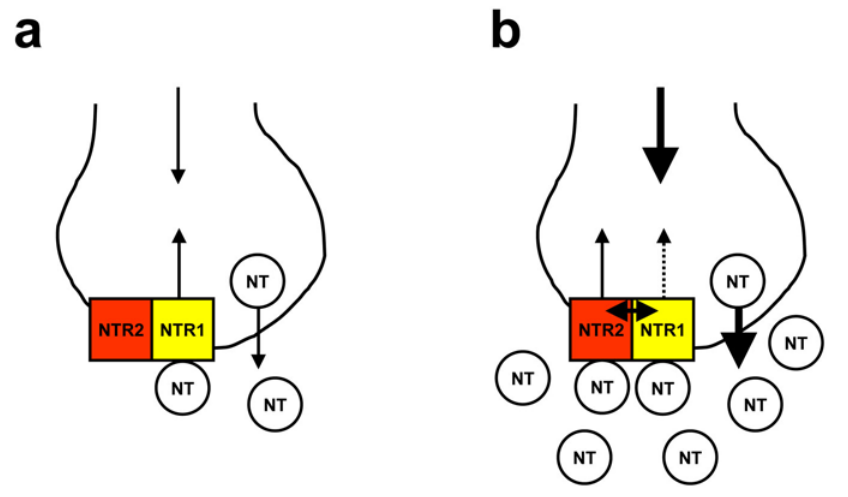
FIGURE 1. Heteromers of isoreceptors: “concentration-dependent switches”. (a) A weak input induces a weak neurotransmitter (NT) release, which activates the receptors with higher affinity for the neurotransmitter (NTR1). (b) A stronger input induces a stronger neurotransmitter release, with additional activation of the receptors with lower affinity (NTR2), which establishes an intermolecular cross-talk between both receptors and induces a different